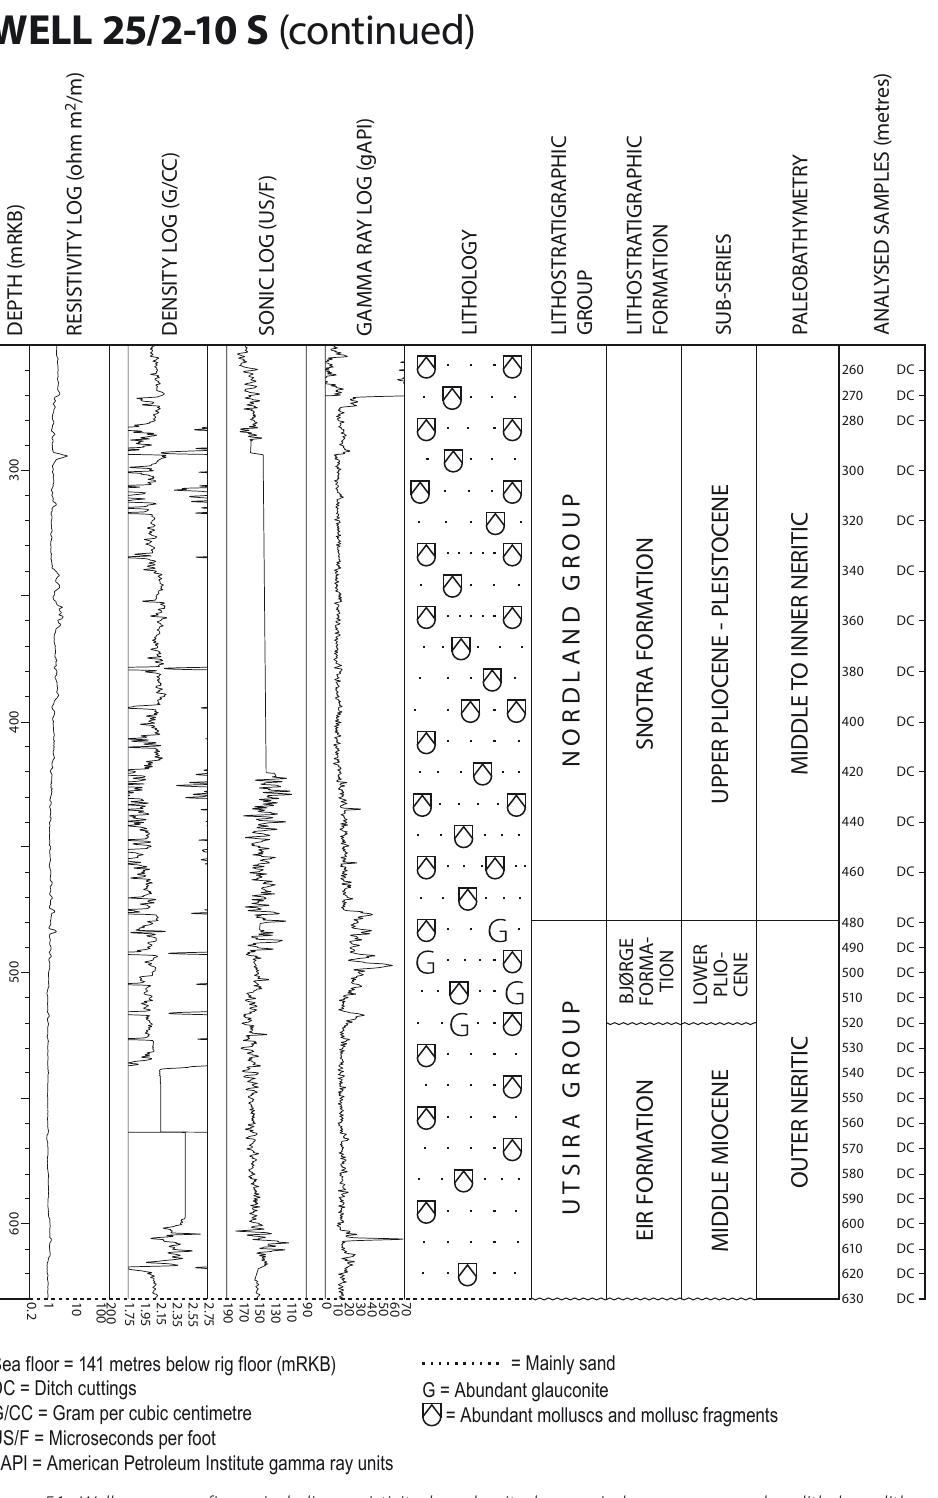
Figure 51. Well summary figure including resistivity log, density log, sonic log, gamma-ray log, lithology, litho- stratigraphic units, sub-series, paleobathymetry and analysed samples for the upper part of the investigated sequence in well 25/2–10 S (middle Miocene to upper Pliocene/Pleistocene) including the well type sections for the Eir and Snotra formations (modified after Eidvin et al.,